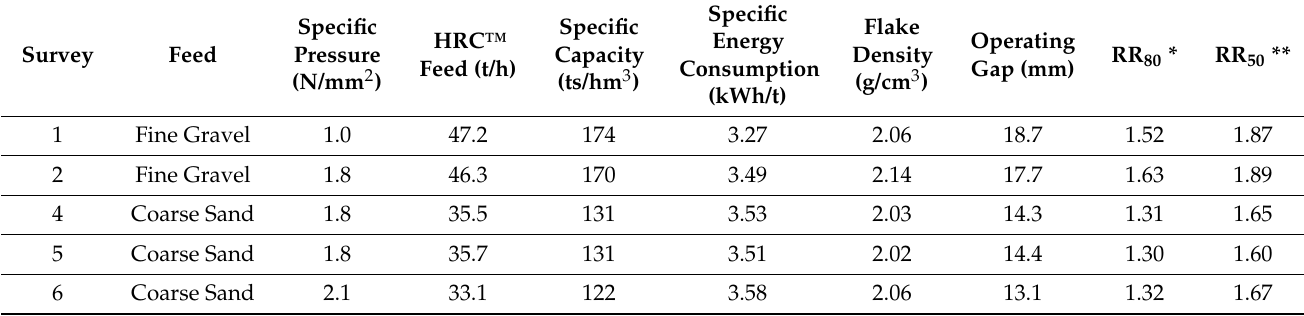
Table 6. Summary of operating conditions and main performance indexes.